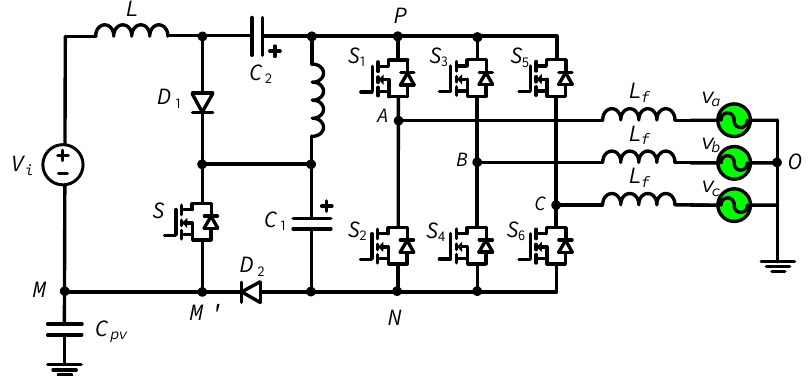
Figure 1. Three-phase active quasi-Z-source inverter (AqZSI).